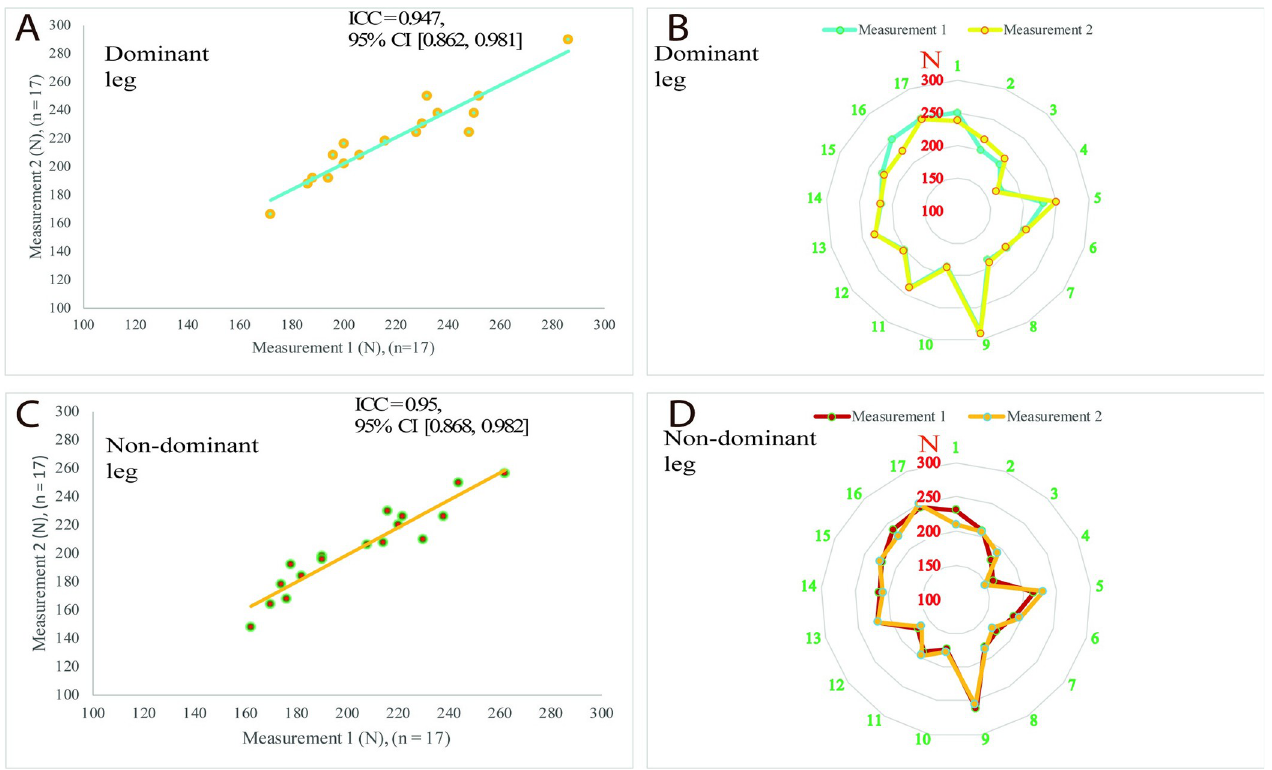
Fig 7. Reliability results from the maximal eccentric hamstring strength measurements for both legs via handheld dynamometry. A: Scatter plots with a regression line for the dominant leg reliability measurements, B: Radar chart for the dominant leg reliability measurements shows agreements between measurements for each participant from 1 to 17, C: Scatter plots with a regression line for the non-dominant leg reliability measurements, D: Radar chart for the non-dominant leg reliability measurements shows agreements between measurements for each participant from 1 to 17. Abbreviations: CI, confidence interval; ICC: Intraclass correlation coefficient; N, Newton; n, sample size.